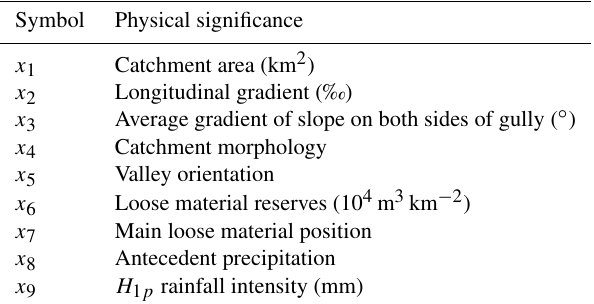
Table 3. The nine indexes used in the prediction model of debris flow